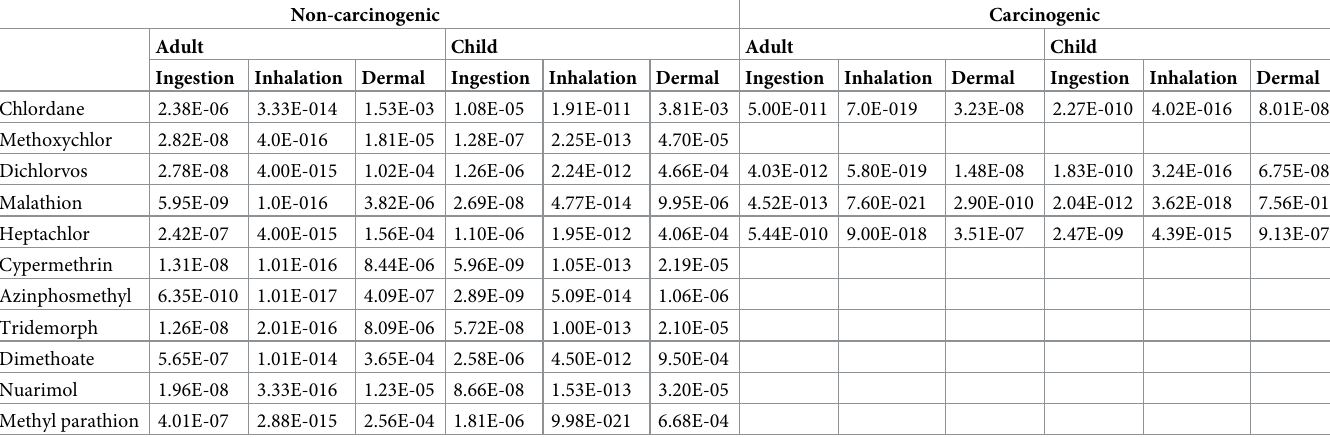
Table 3. Estimation of Chronic daily intake (CDI) and hazard quotient (HQ) for pesticide residues in sediment from lower